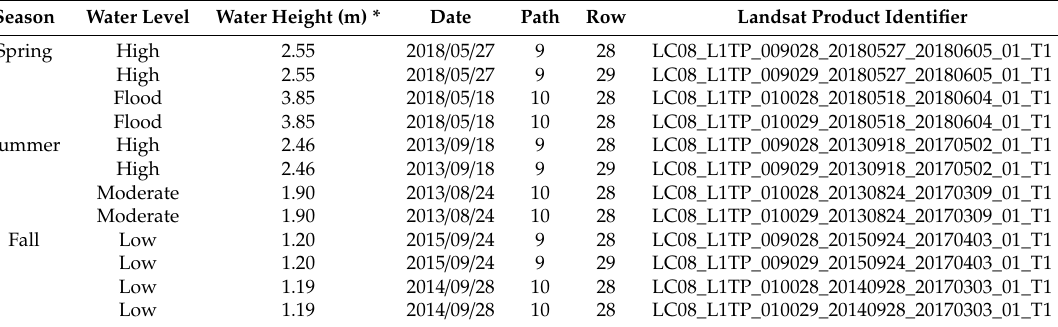
Table 5. List of Landsat-8 Images used in the study as a function of the season and water level. Season Water Level Water Height (m) * Date